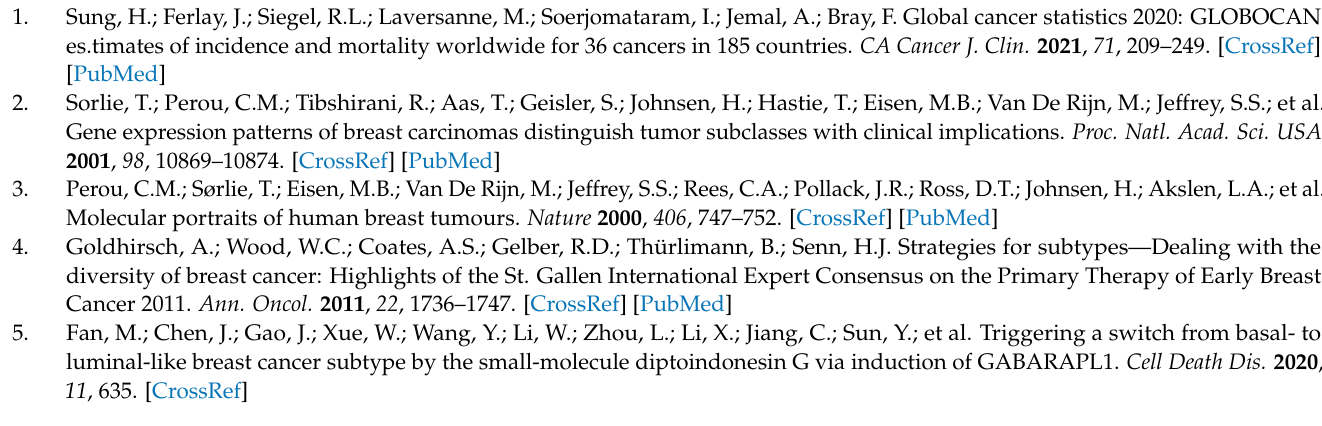
ting data; Figure S2: Kaplan-Meier curves of survival and relapse-free survival for all the breast cancer patients categorized into the three groups based on the RA- and ERK-upregulated genes; Table S1: Genes up- or down-regulated by the poly(DMAAm-co-APTMA) hydrogel; Table S2: Gene sets significantly upregulated by the poly(DMAAm-co-APTMA) hydrogel; Table S3: Gene sets significantly overlapped with RA- and ERK-upregulated